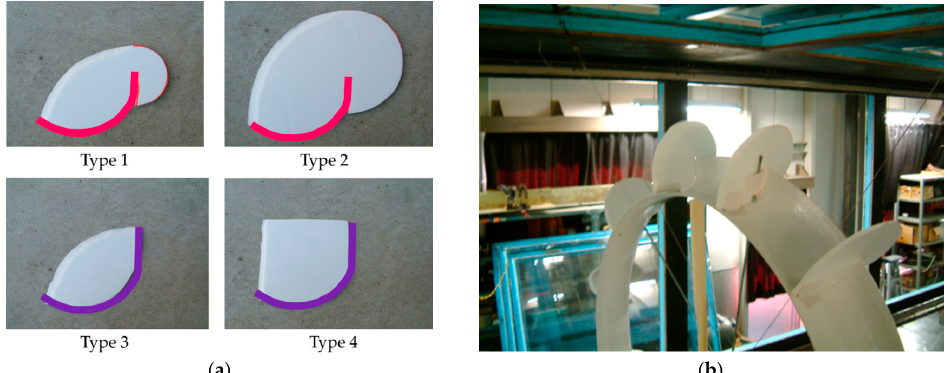
Figure 4. Schemes of WLT and the duct with the shape of Ci type diffuser: ( a ) Representative configuration parameters of the duct of WLT; ( b ) In situ photograph of the duct ( h = 0.05 D throat ).